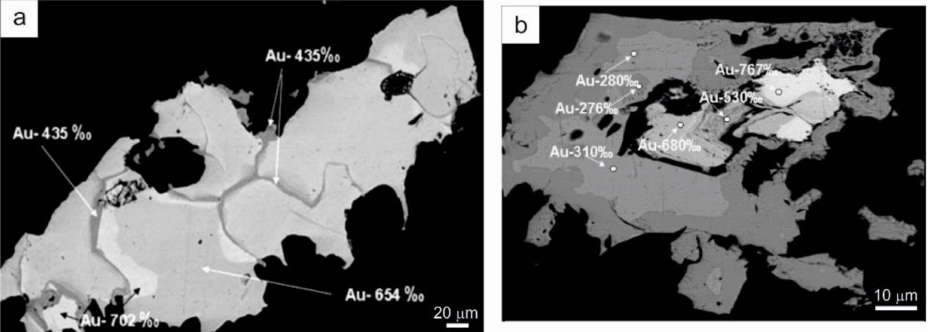
Figure 9. Heterogeneity of native gold within one grain: ( a ) Kupol deposit (from 435‰ to 702‰); ( b ) Dalnee deposit (from 276‰ to 767‰), taken in reflected